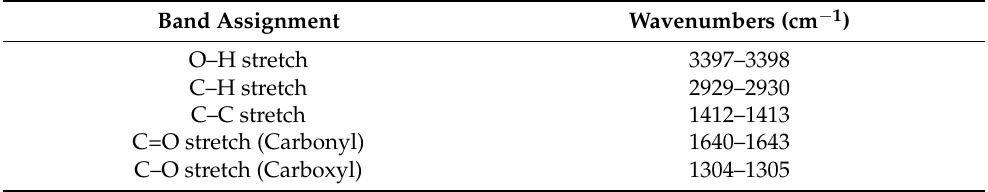
Table 3. FTIR-ATR spectra band assignment for adlay